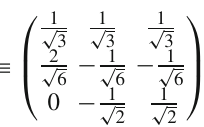
Fig. 3 The allowed region on Re [ τ ] –Im [ τ ] plane, where observed CKM mixing angles and δ CP are reproduced. The solid curve is the boundary of the fundamental domain, | τ | = 1